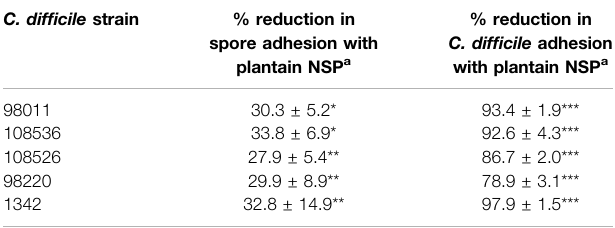
TABLE 2 | Soluble NSP from plantain inhibits epithelial adhesion of C. dif fi cile spores and vegetative cells. C. dif fi cile strain % reduction in spore adhesion with plantain NSP